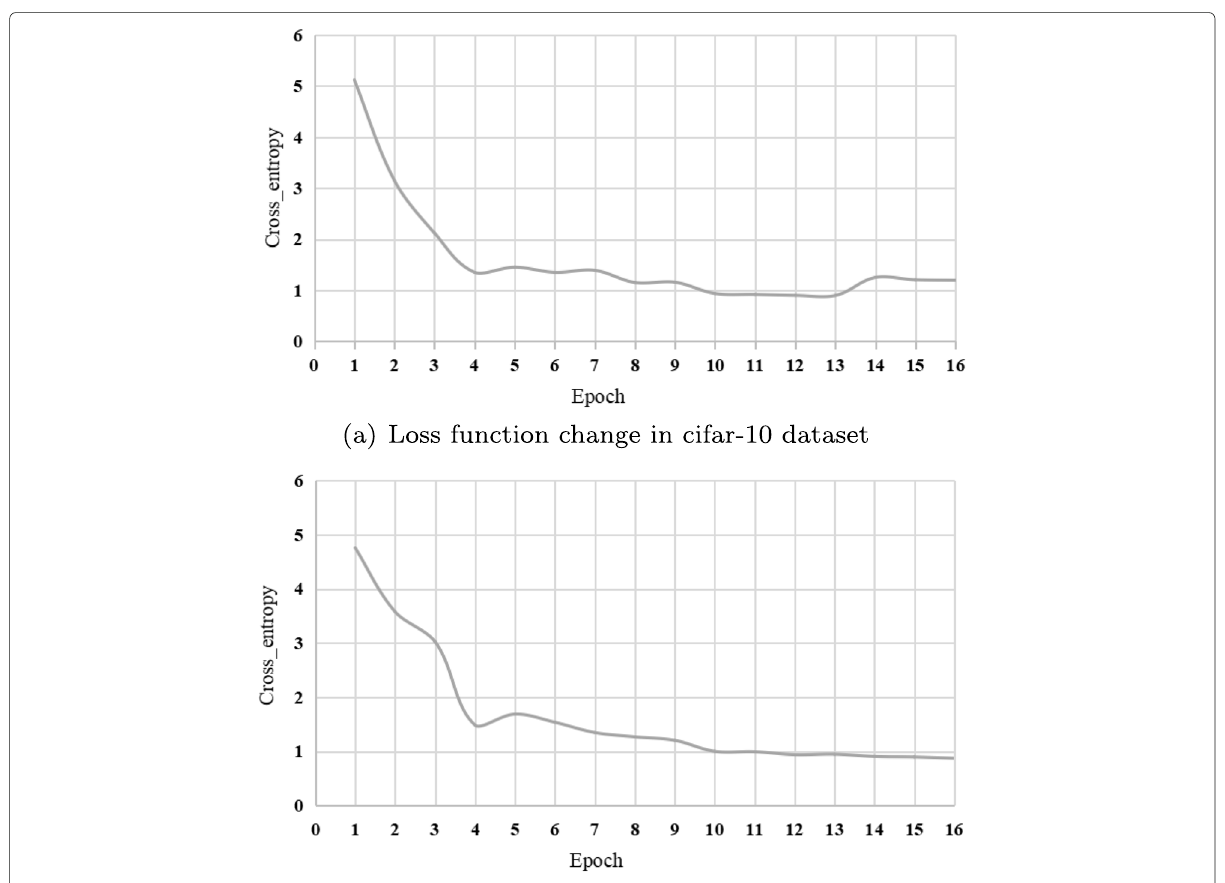
Fig. 6 Loss function change in different dataset